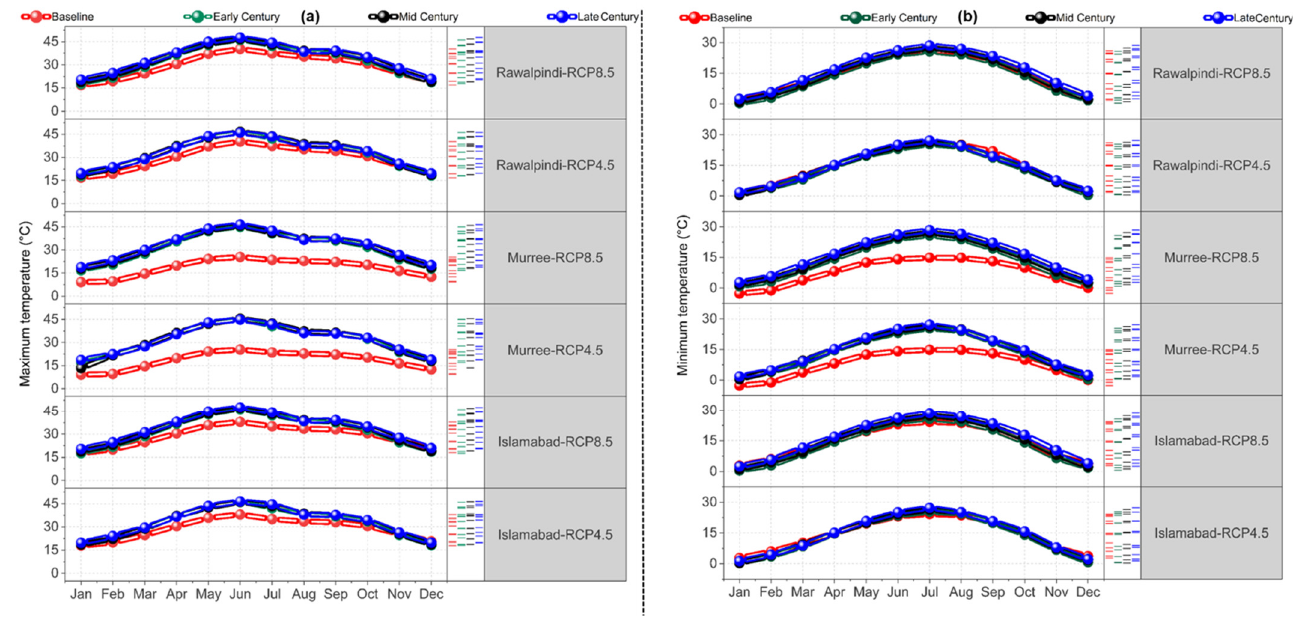
Figure 6. Monthly ( a ) maximum temperature ( T max ) and ( b ) minimum temperature ( T min ) profiles of different cities (Islamabad, Rawalpindi, and Murree) with their climate stations (RCP-4.5 and RCP-8.5) for time period of baseline, early, mid, and late century.